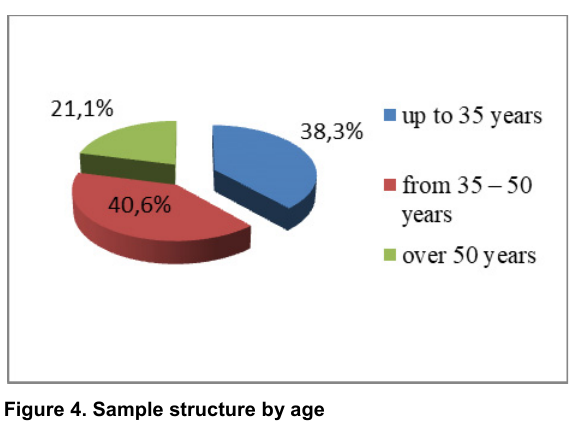
Figure 3. Sample structure by gender